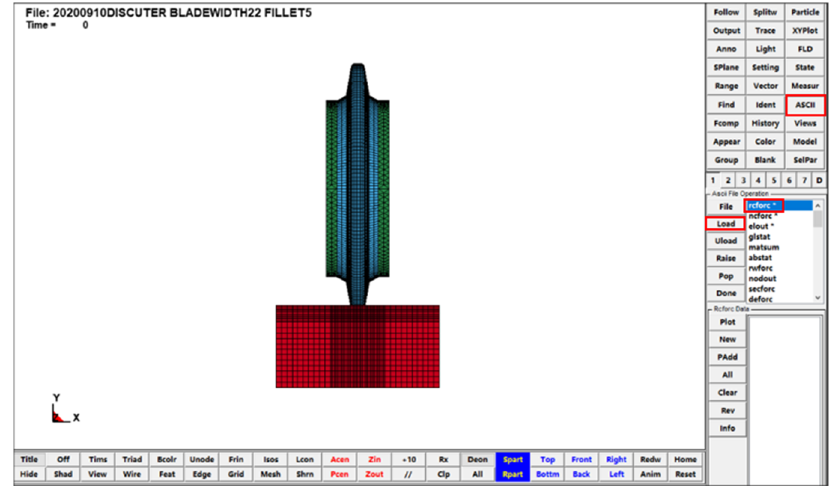
Figure 12. Fourteen different blade types of disc cutters.